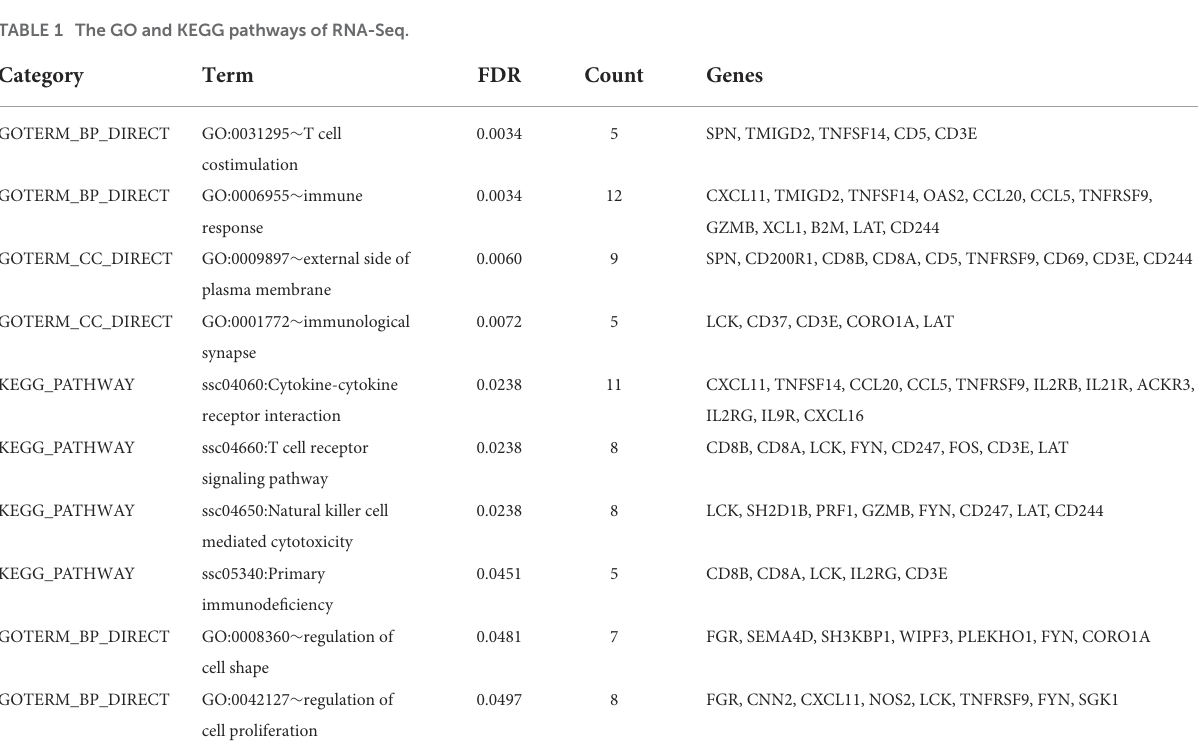
TABLE 1 The GO and KEGG pathways of